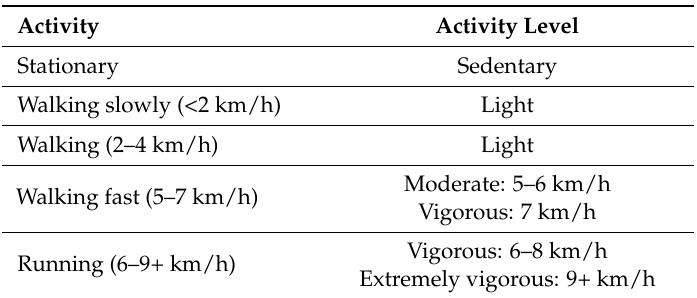
Table 1. Activity category and corresponding activity